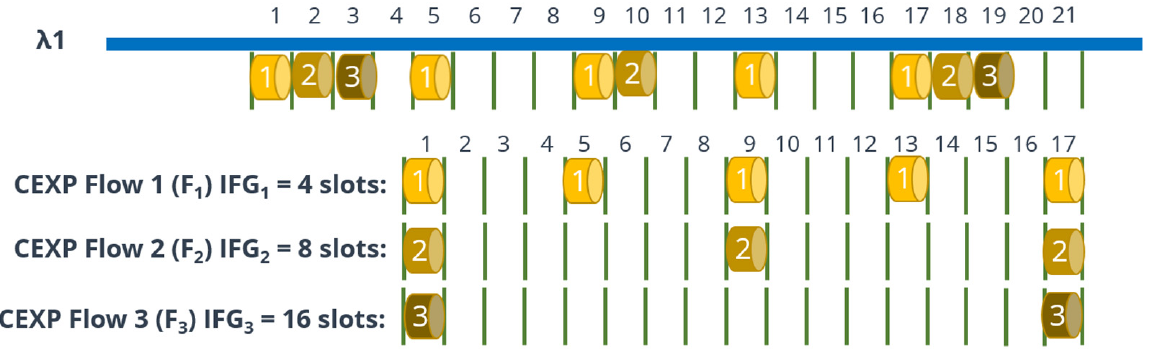
Figure 5. Example operation of the CEXP-Fit algorithm for 3 CEXP flows with IFGs of 4, 8, and 16 slots, respectively.